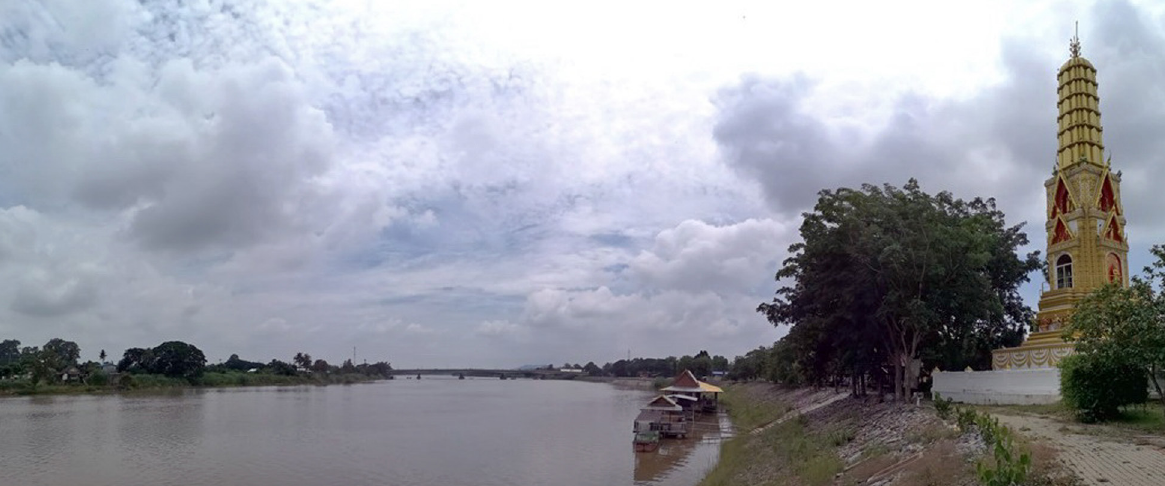
Fig. 5. Wat Phra Prang Luang archaeological